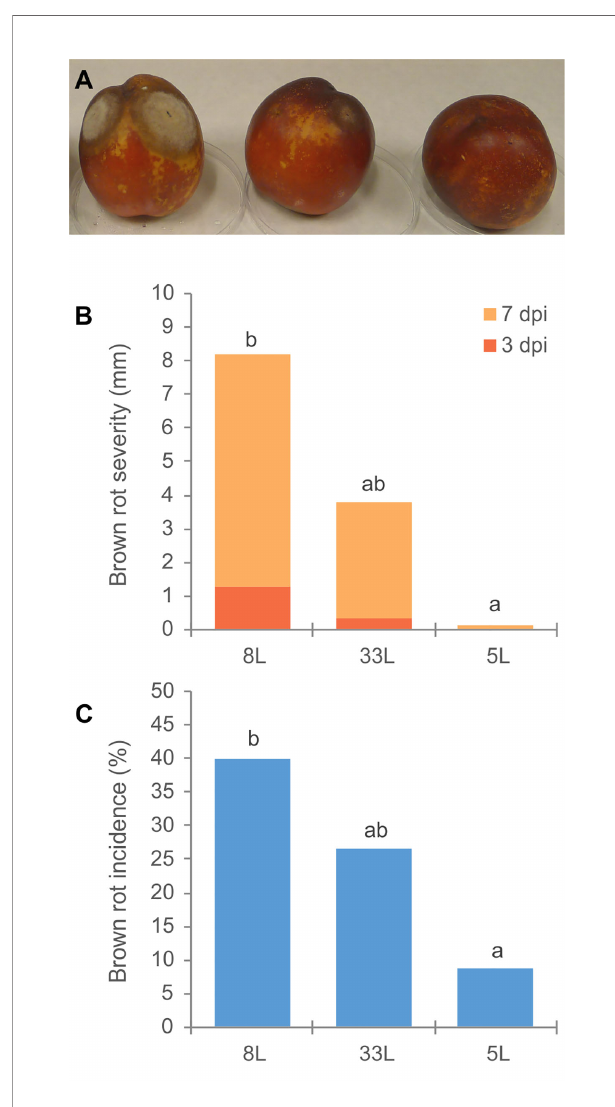
FIGURE 1 | (A) Disease assessment of unwounded nectarine fruit cv. `Big Top´; in order 8L, 33L and 5L M. laxa isolate. (B) Brown rot severity (mm) caused by M. laxa isolates at 3 and 7 days after inoculation on nectarine fruit cv. Big Top´. (C) Brown rot incidence (%) by M. laxa isolates 12 days after inoculation. Data represent the mean of three experiments with three inoculations per fruit, and fi ve fruit per isolate and experiment. Data were analyzed by analysis of variance, means values with the same letter are not signi fi cantly different (P ≤ 0.05) according Student – Newman – Keuls multiple range